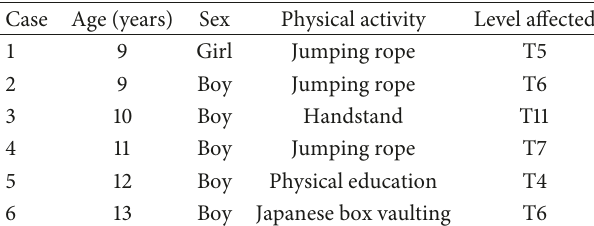
Figure 1: Magnetic resonance images at the initial visit showing low signal on T1WI (a), relatively high signal on T2WI (b), and high signal on short tau inversion recovery (STIR) image (c) in the upper part of the vertebral body at T11 without deformation of the cortical endplate (arrow). At 1-month follow-up later, signal changes had diminished on T1, T2, and STIR images, respectively (d, e, and f, arrowhead). Table 1: Demographic characteristics and history of injury in 6 children with vertebral bone